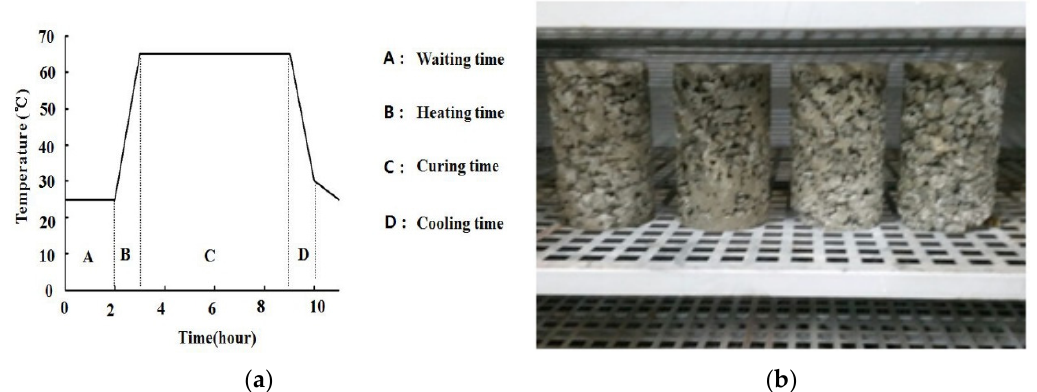
Figure 2. Curing of porous concrete for plant growth. ( a ) Accelerating curing process; ( b ) Curing